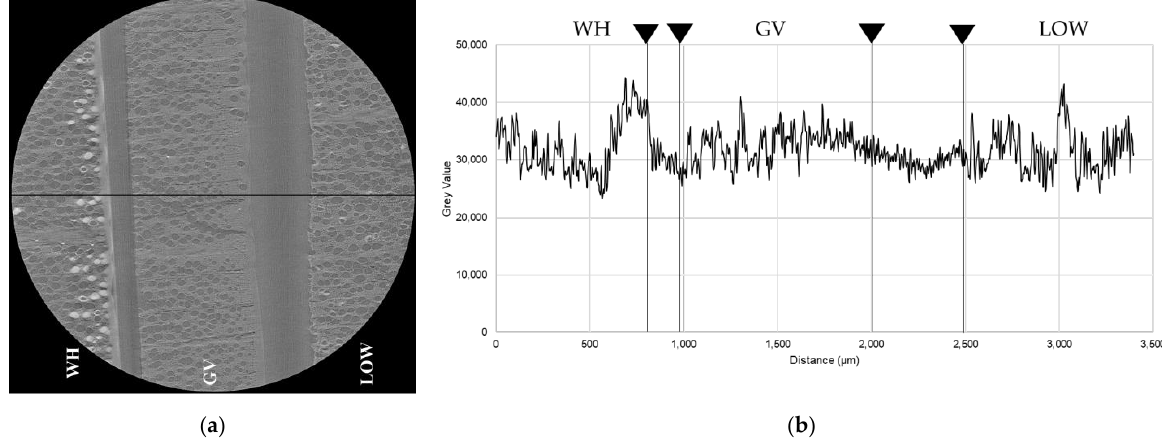
Figure 7. Sample Series 2 Cu target down side (WH, GV, LOW); ( a ) visualization result and the plot profile line; ( b ) plot profile graphic.